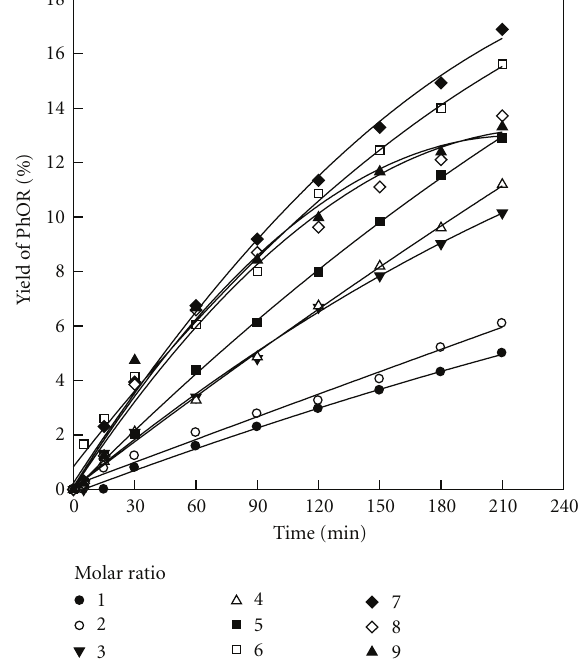
Figure 3: E ff ect of molar ratio of allylbromide to PhONa. T = 50 ◦ C, agitation = 400rpm. Aqueous phase (35cm 3 ): deionized water, phenol = 0.011 mol, NaOH = 0.018 mole. Organic phase (35cm 3 ): 1,2-C 2 H 4 Cl 2 , membrane reactor H1, membrane =